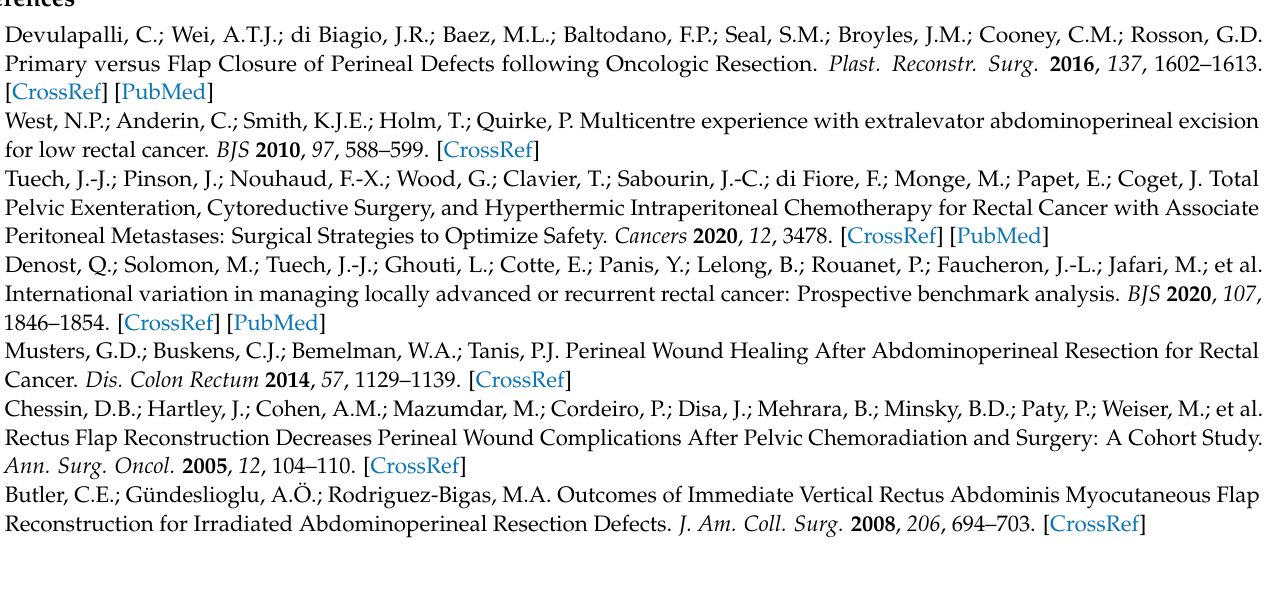
Table S2: Southampton wound assessment scale, Table S3: Newcastle Ottawa scale details. Table S4–S21 studies